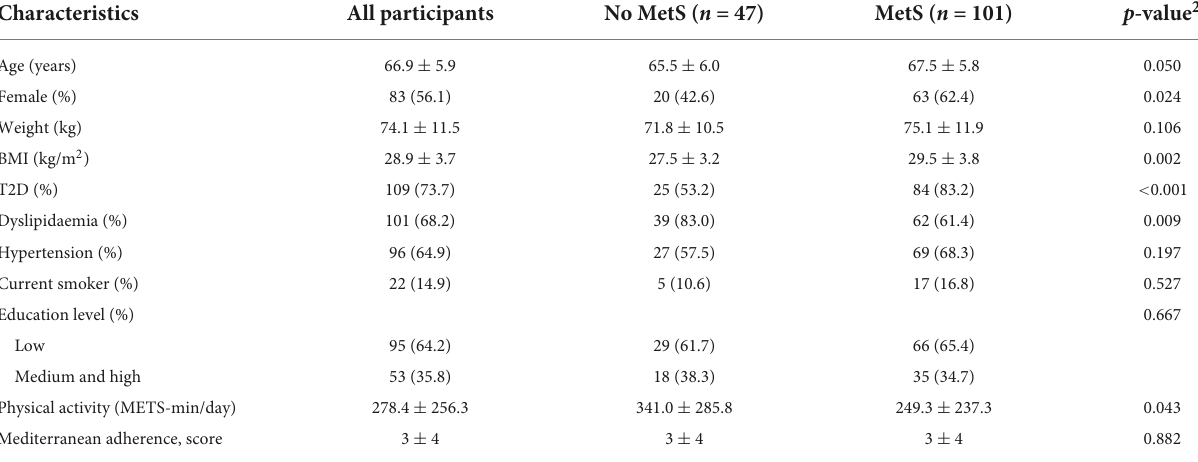
TABLE 1 Baseline characteristics of participants according to MetS 1 .